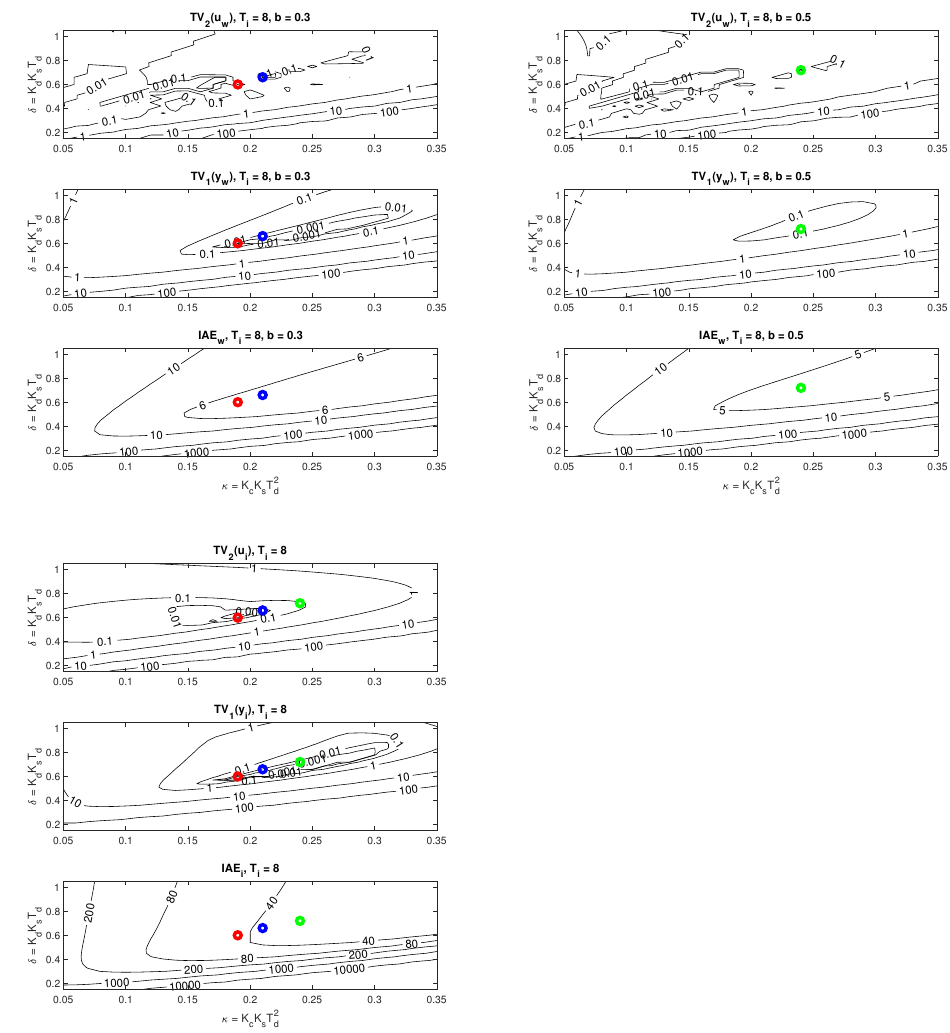
Figure 7. Cross-sections of PP (41) corresponding to setpoint responses (above) and disturbance responses (below) from Figure 6 for the optimal parameters (49) fulfilling the constraints (46) with (cid:101) = 0.001 (red), (cid:101) = 0.01 (blue), and (cid:101) = 0.1